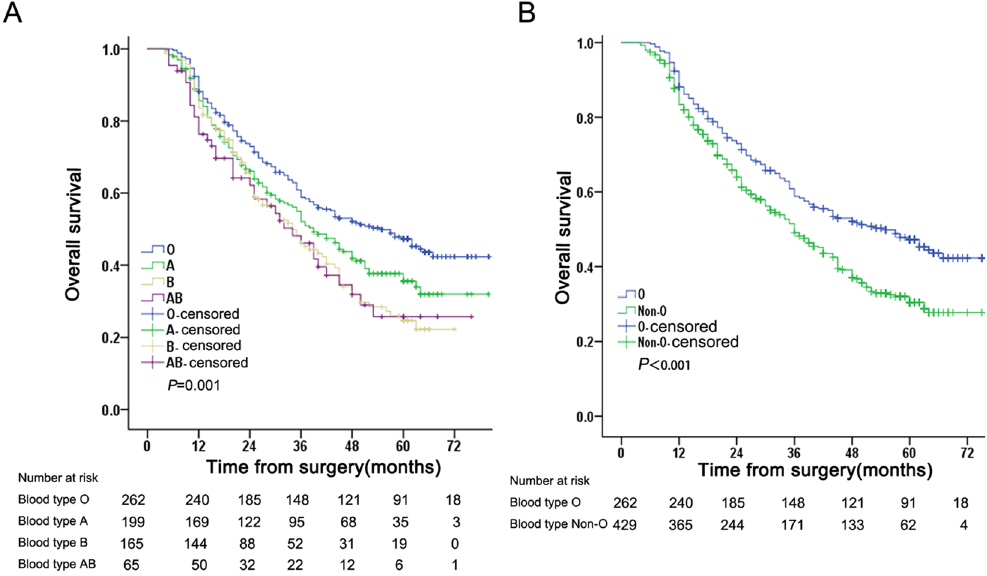
Figure 1. Overall survival (OS)for of HCC patients. ( A ). OS according to ABO blood types. ( B ). OS according to blood type O and non-O blood